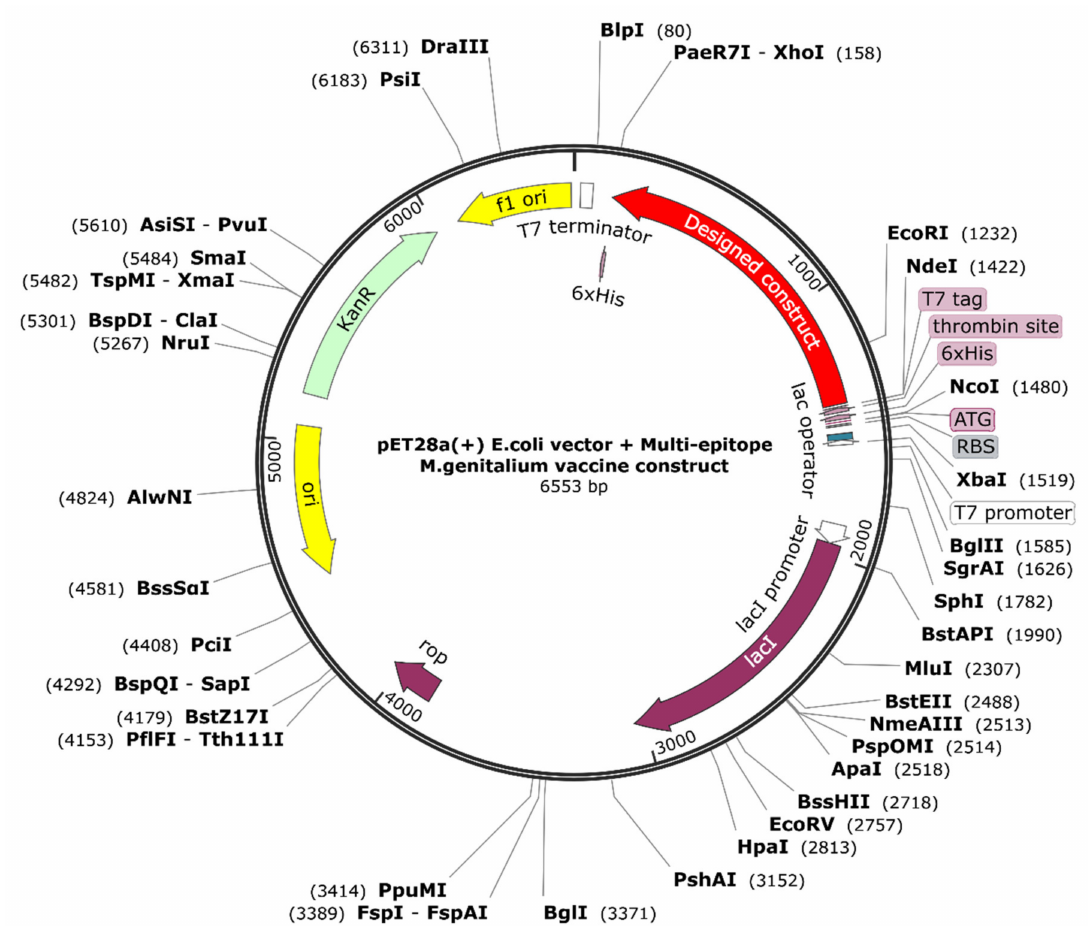
Figure 12. In-silico-cloned vaccine construct for E. coli expression system, colored with a red arrow, shown in a black vector backbone of pET28